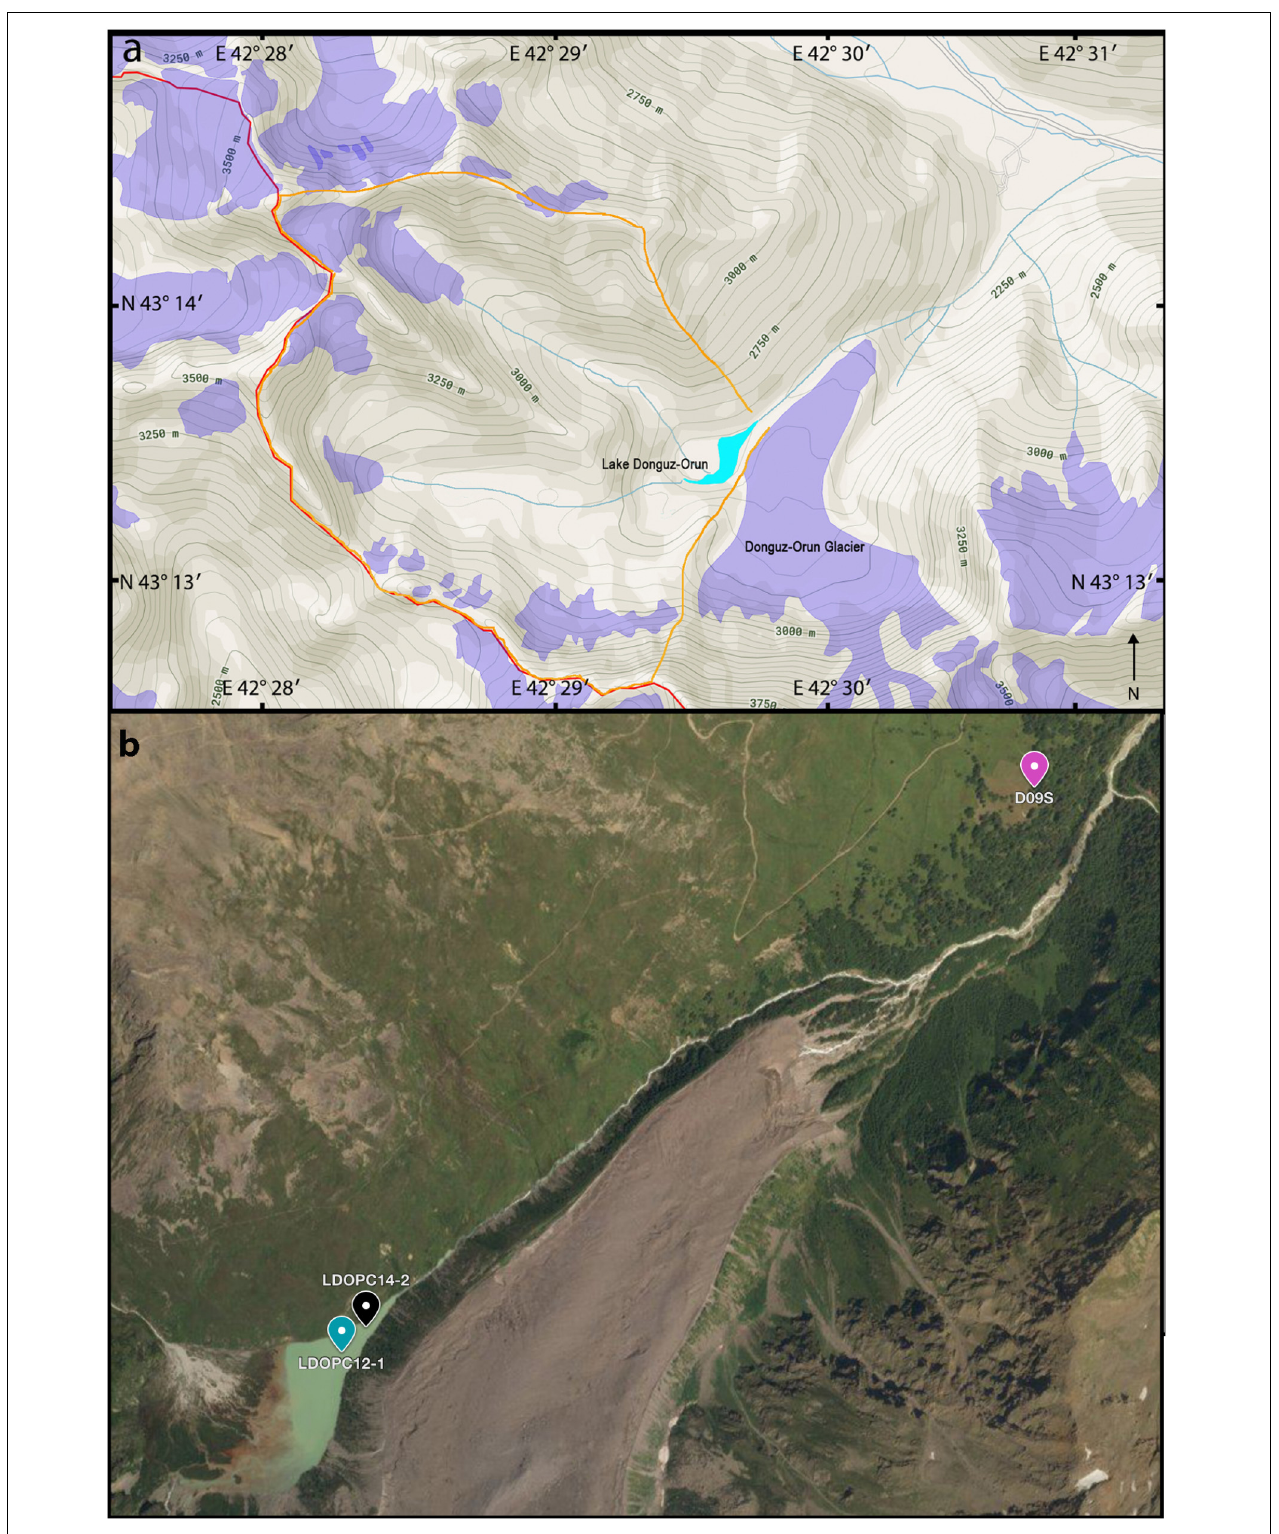
FIGURE 2 | (a) Schematic layout of the lake setting. Translucent purple outlines mark glaciers according to GLIMS database; orange line indicates lake’s catchment area, red line marks administrative border; (b) Aerial view of Lake and Glacier Donguz-Orun. The pins indicate coring sites and location of the tree ring site D09S. Image courtesy: